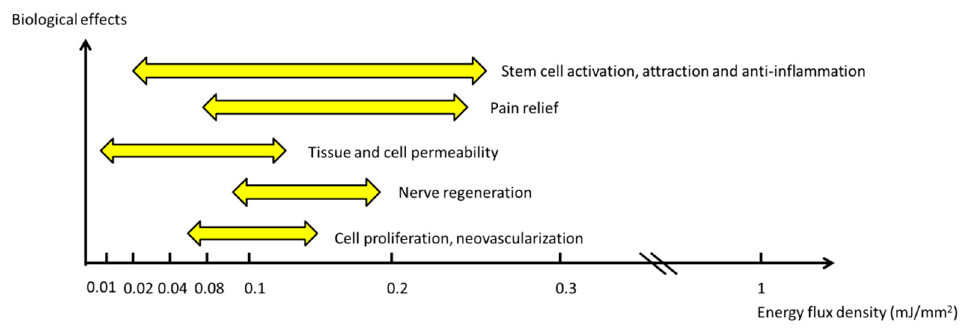
Figure 2. The biological effects associated with related energy levels of ESWT.